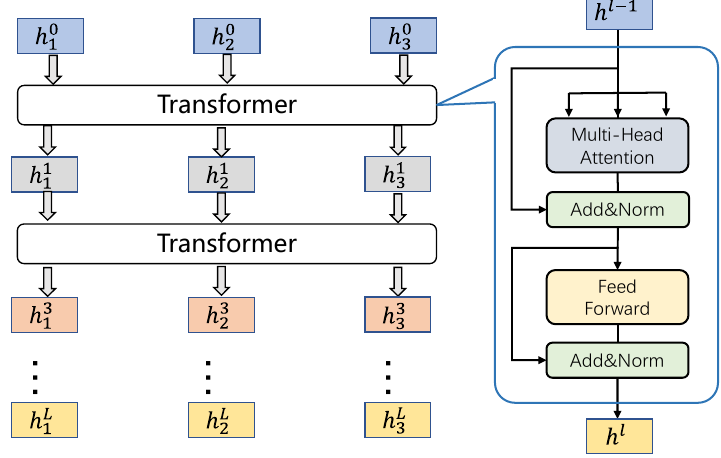
Figure 3. Document encoder structure.